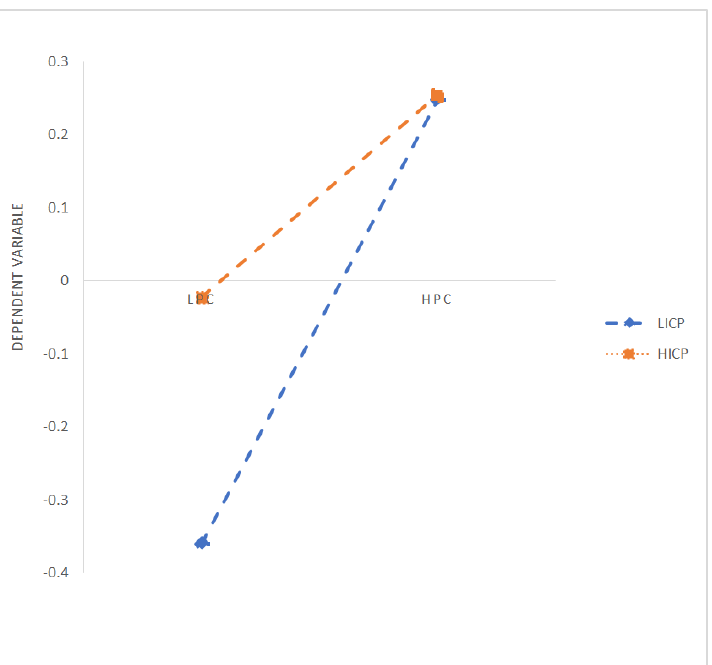
Figure 2. Moderating Effects of Internal Control Personality (Parental Communication). Notes: LPT: Low Parental Trust, HPT: High Parental Trust; LPC: Low Parental Communication, HPC: High Parental Communication; LPA: Low Parental Alienation, HPA: High Parental Alienation; LICP: Low Internal Control Personality, HICP: High Internal Control